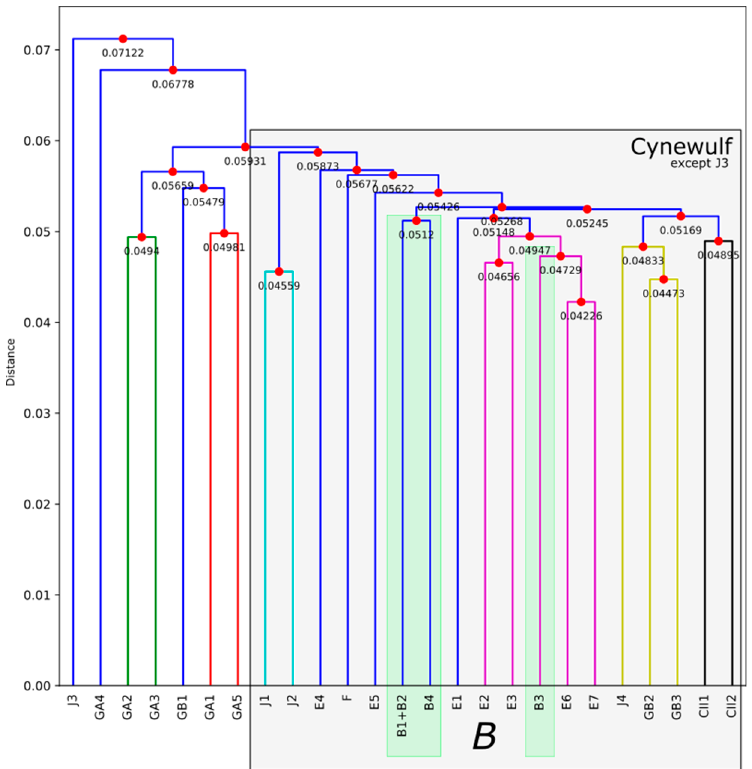
Figure 15. Andreas B with the Cynewulfian group.